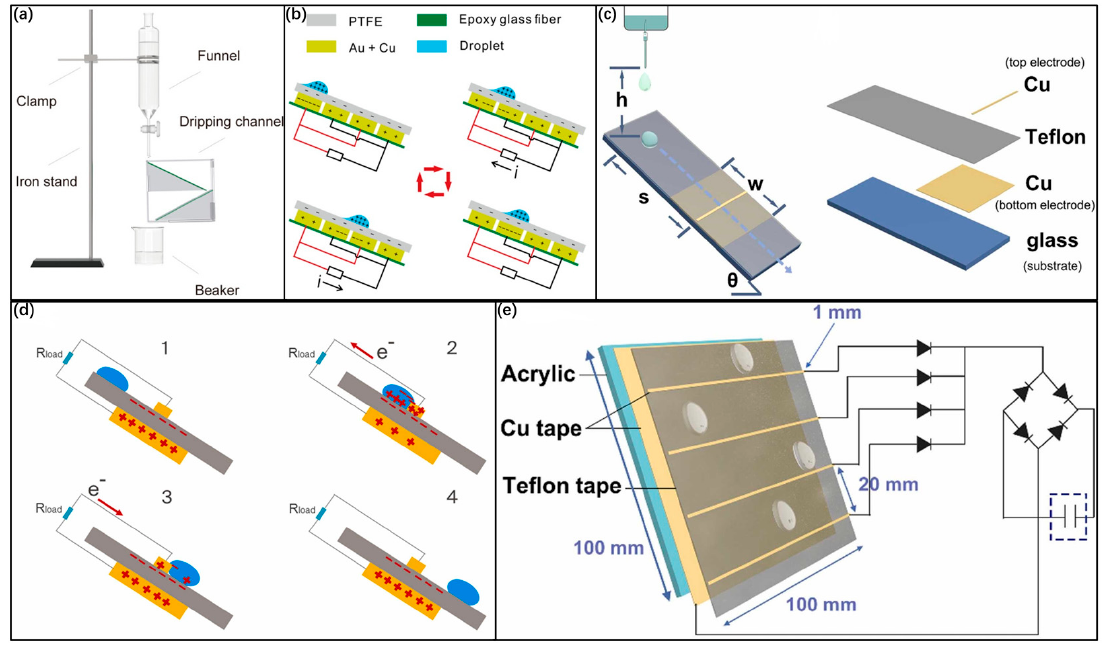
Figure 3. ( a ) The model and ( b ) working mechanism of L-TENG [47]. ( c ) The model and ( d ) working mechanism of D-TENG [50]. ( e ) D-TENG-based droplet energy harvester model and charging circuit diagram [50].